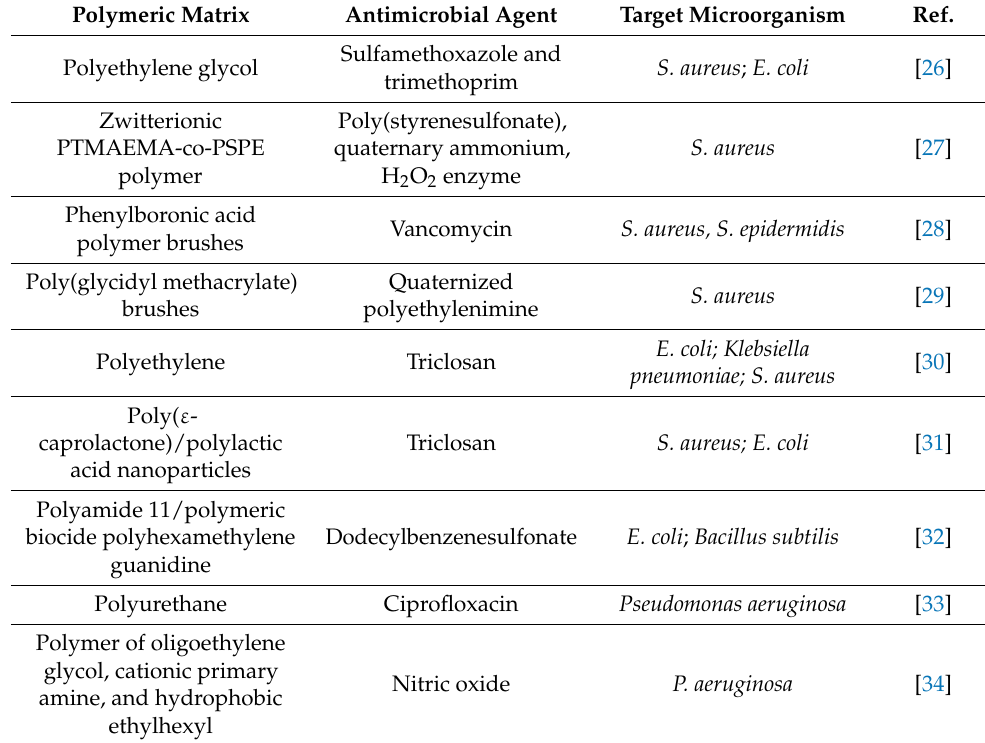
Table 1. Polymers loaded with various antimicrobial